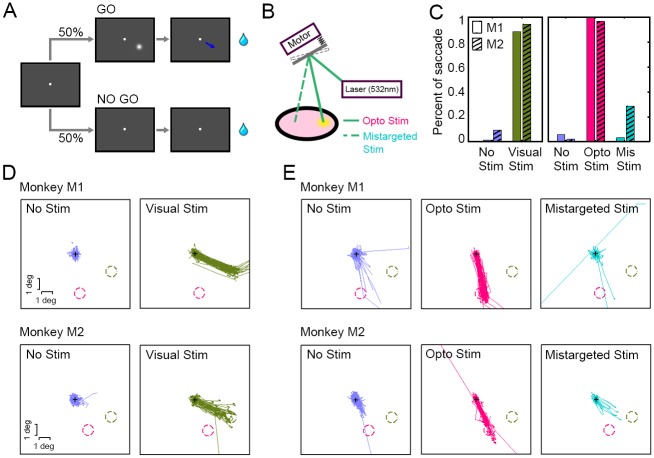
Behavior induced by visual versus optogenetic stimulation in V1.(A) “GO”/“NO GO” visual object detecting task. Monkeys were trained to report the onset of a visual cue (either a visual stimulus—Visual Stim—or an artificial visual perception induced by optogenetic stimulus—Opto Stim) by producing an eye movement. Each trial began when the NHP fixated the central fixation point. In the GO condition, monkeys were required to make a saccade within 500 ms of the cue onset to obtain a juice reward. In the NO GO condition, no stimulus was presented, and monkeys were tasked with maintaining fixation for 2,000 ms to get a juice reward. (B) An apparatus used for redirecting laser pulses towards a nearby cortical area not transduced with C1V1 (Mistargeted Stim, see insert). (C) Analysis of behavior in two monkeys (M1 & M2) during the Visual Stim block (No Stim [blue] and Visual Stim [green]) versus the Opto Stim block (No Stim [blue], Opto Stim [red], and Mistargeted Stim [teal]). The trial numbers that we recorded for the five conditions (No Stim, Visual Stim, No Stim, Opto Stim, Mis Stim) for Monkey M1 were {70, 94, 244, 96, 62}, respectively, and {32, 50, 139, 51, 14} for Monkey M2, respectively. (D) Saccadic trajectories in the Visual Stim block. The green dashed circles indicate the location of the Visual Stim, and the red dashed circles denote the receptive fields of C1V1-expressing sites. (E) Saccadic trajectories in the Opto Stim block. With Opto Stim, both monkeys uniformly targeted their eye movements to the receptive fields of the C1V1-expressing site. Data can be found at https://github.com/EastRainju/Opto-TP. C1V1, ChR1/VChR1; NHP, nonhuman primate; PMT, photomultiplier; V1, primary visual cortex.